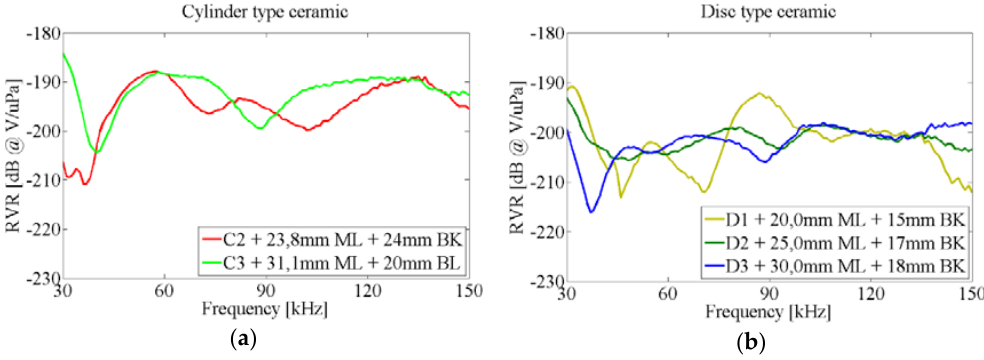
Figure 19. RVR of ceramics with backing and matching layer glued to the vessel. ( a ) Cylinder type ceramic; ( b ) Disc type ceramic.